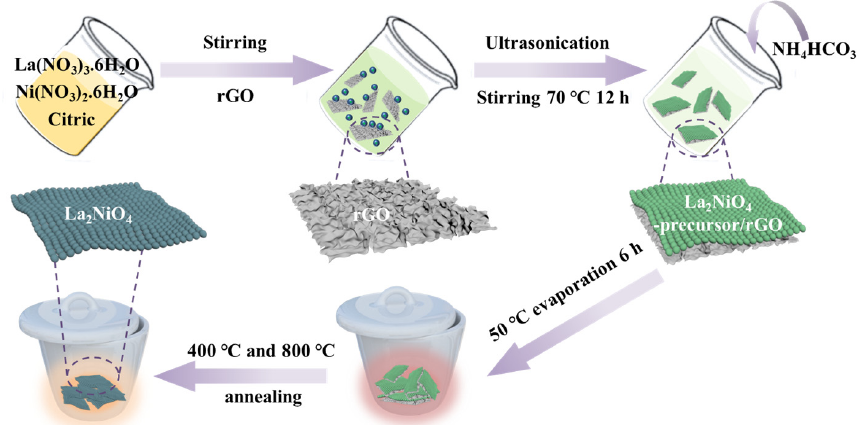
Figure 1. Schematic illustration of the preparation of La 2 NiO 4 as a UOR catalyst. (The green and dark green balls represent La 2 NiO 4 precursor and La 2 NiO 4 , respectively).